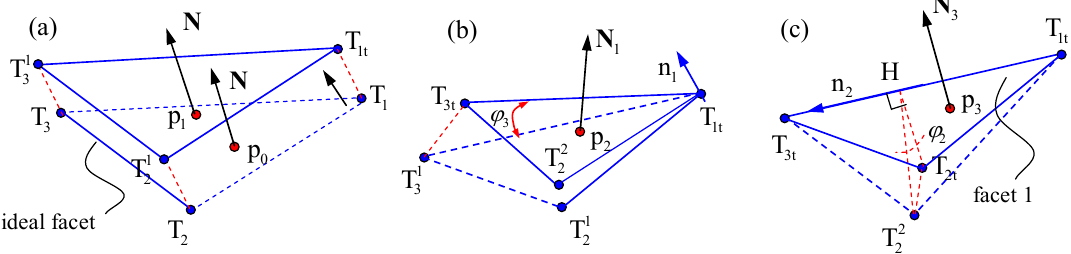
Figure 3. The mirror unit through OneT ‐ TwoR rigid body motion as it moves from the ideal facet to facet 1 by ( a ) translational motion, ( b ) rotation around point T 1t , and ( c ) rotation about axis T 1t T 3t . In Equation (1), where t 1 , t 2 , and t 3 are the position error vectors of the feature points T 1 , T 2, and T 3 determined by photogrammetry